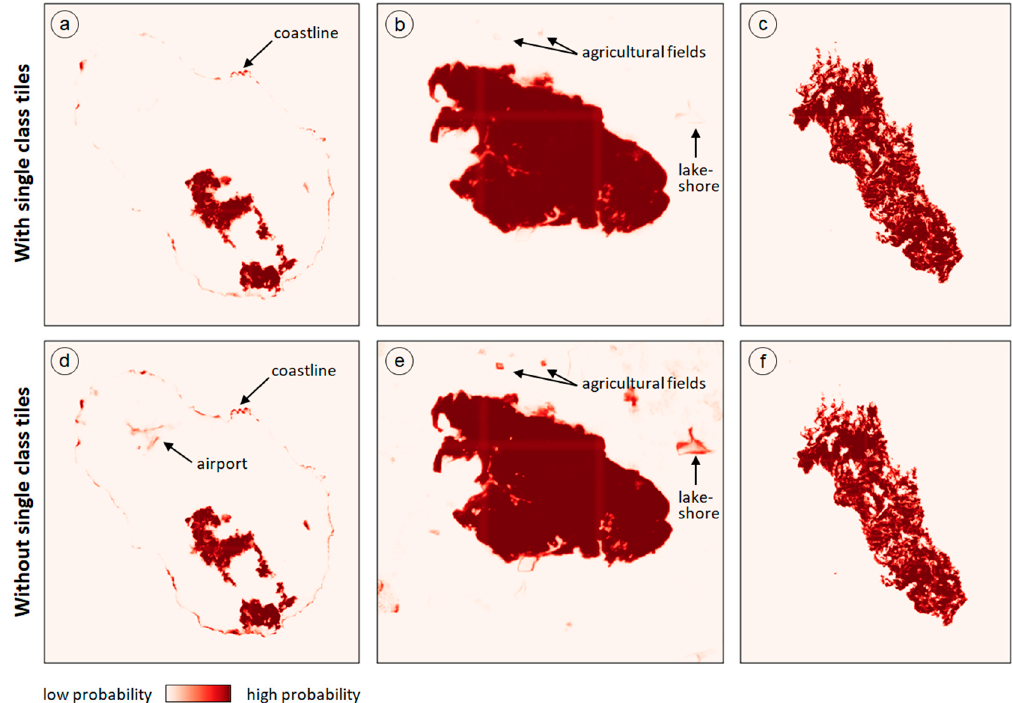
Figure 9. U-Net probability maps for the three study areas indicating the pixels’ probability of being burned. ( a – c ) Prediction using a model trained with all available tiles (corresponds to our final model); ( d – f ) prediction using a model in which single class tiles were excluded.